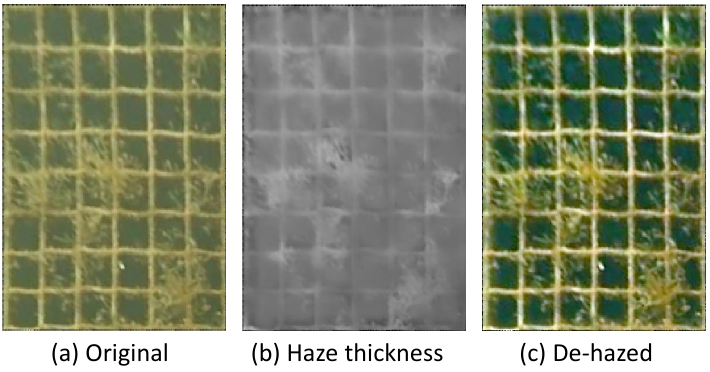
Figure 4. A sample of underwater image de-hazing. ( a ) original image; ( b ) haze thickness; and ( c ) de-hazed